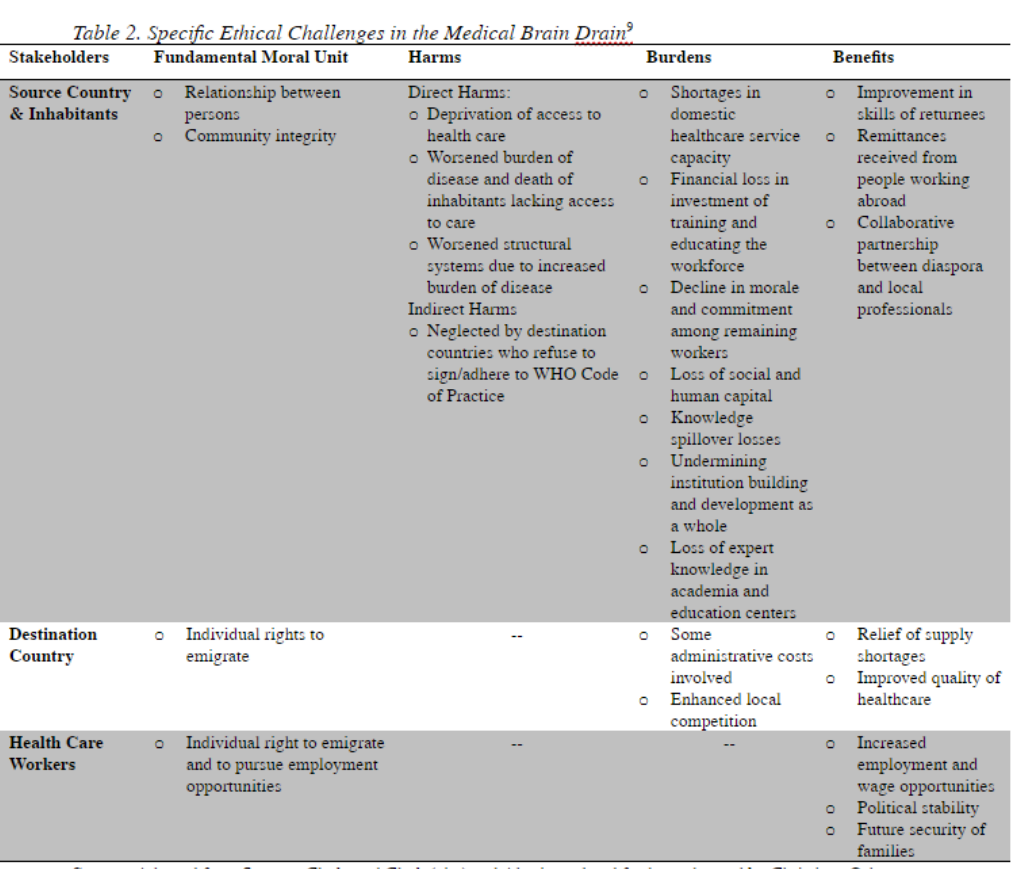
Table 2. Specific Ethical Challenges in the Medical Brain Drain